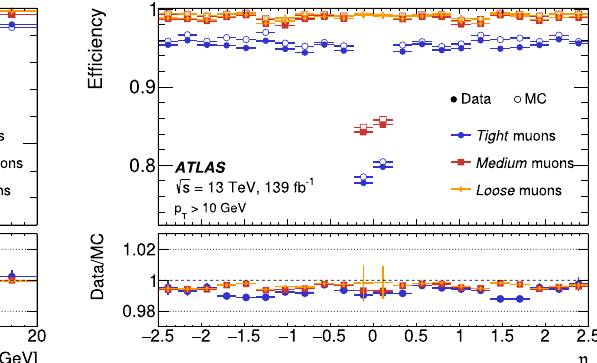
of the measurement in collision data. The statistical uncertainty in the efficiency measurement is smaller than the size of the markers, and thus not displayed. The panel at the bottom shows the ratio of the measured to predicted efficiencies, with statistical and systematic